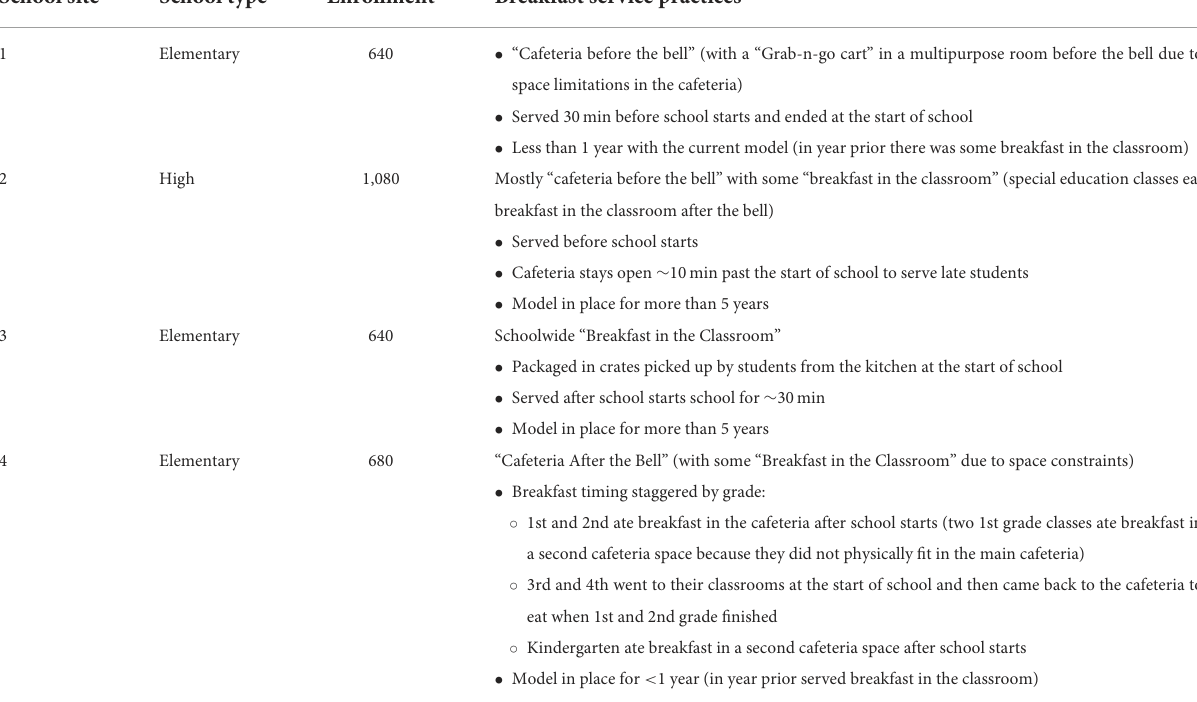
TABLE 3 Description of breakfast model by